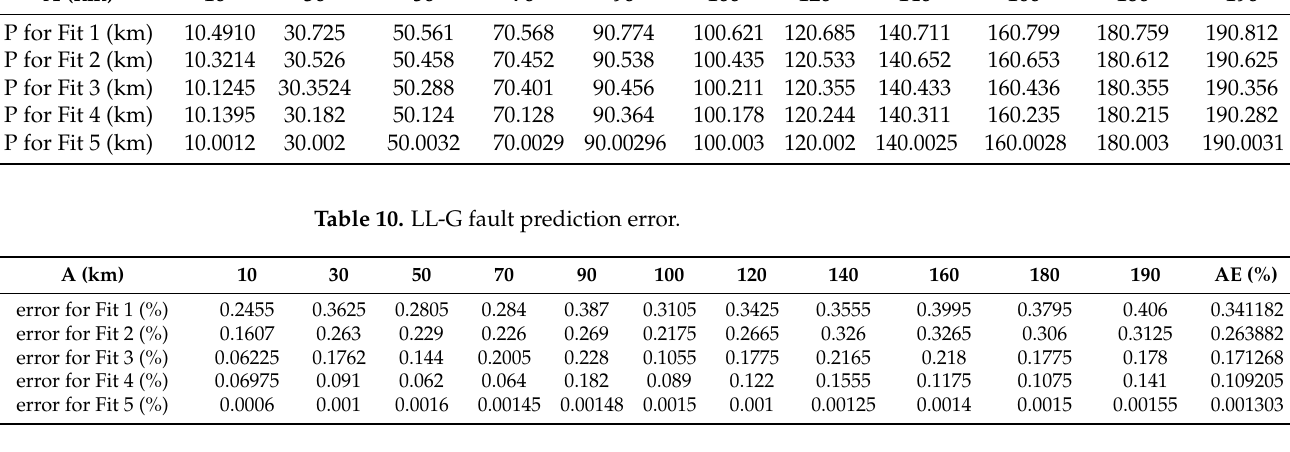
Table 9. Actual (A in km) and predicted (P in km) fault locations under LL-G fault scenario. Table 5. Actual (A in km) and predicted (P in km) fault locations under LG fault scenario.